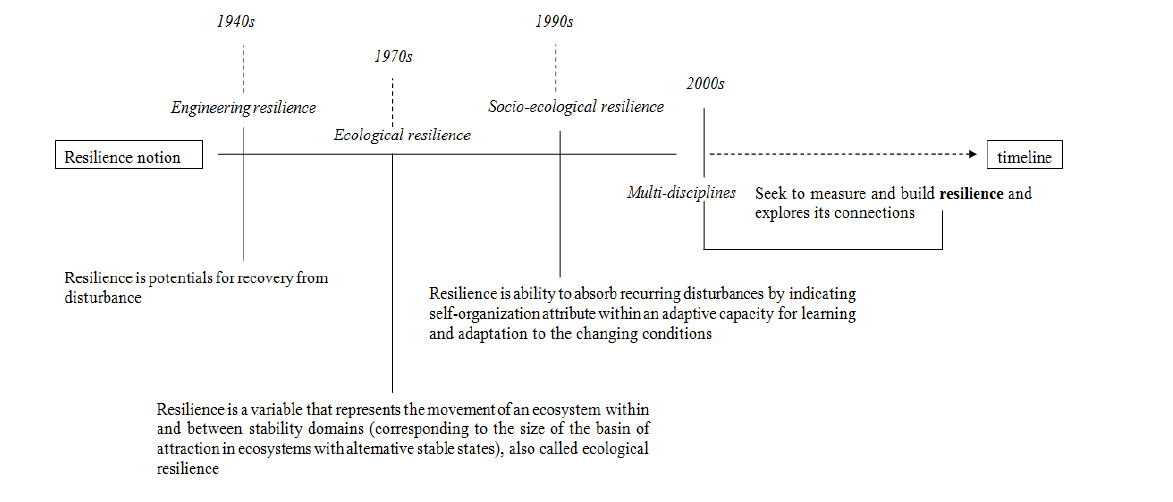
Table 1. Resilience framework development